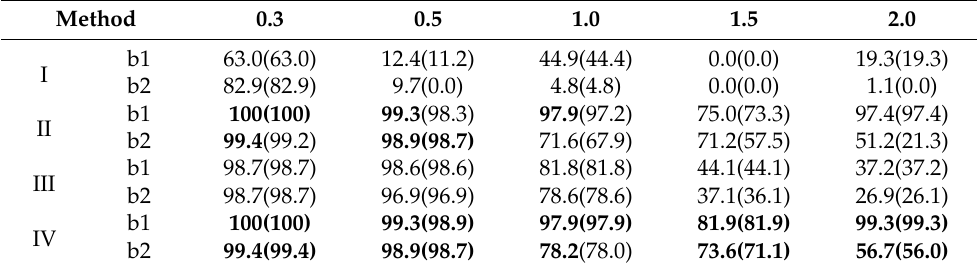
Table 4. SFSE ambiguity fixing rate and correct fixed rate of various designed and actual baseline lengths (GPS + BDS observations,